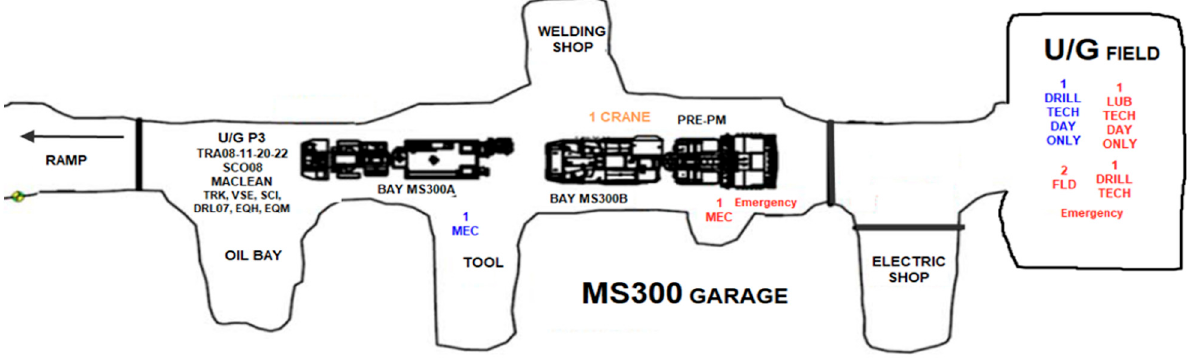
Figure 5. Underground garage